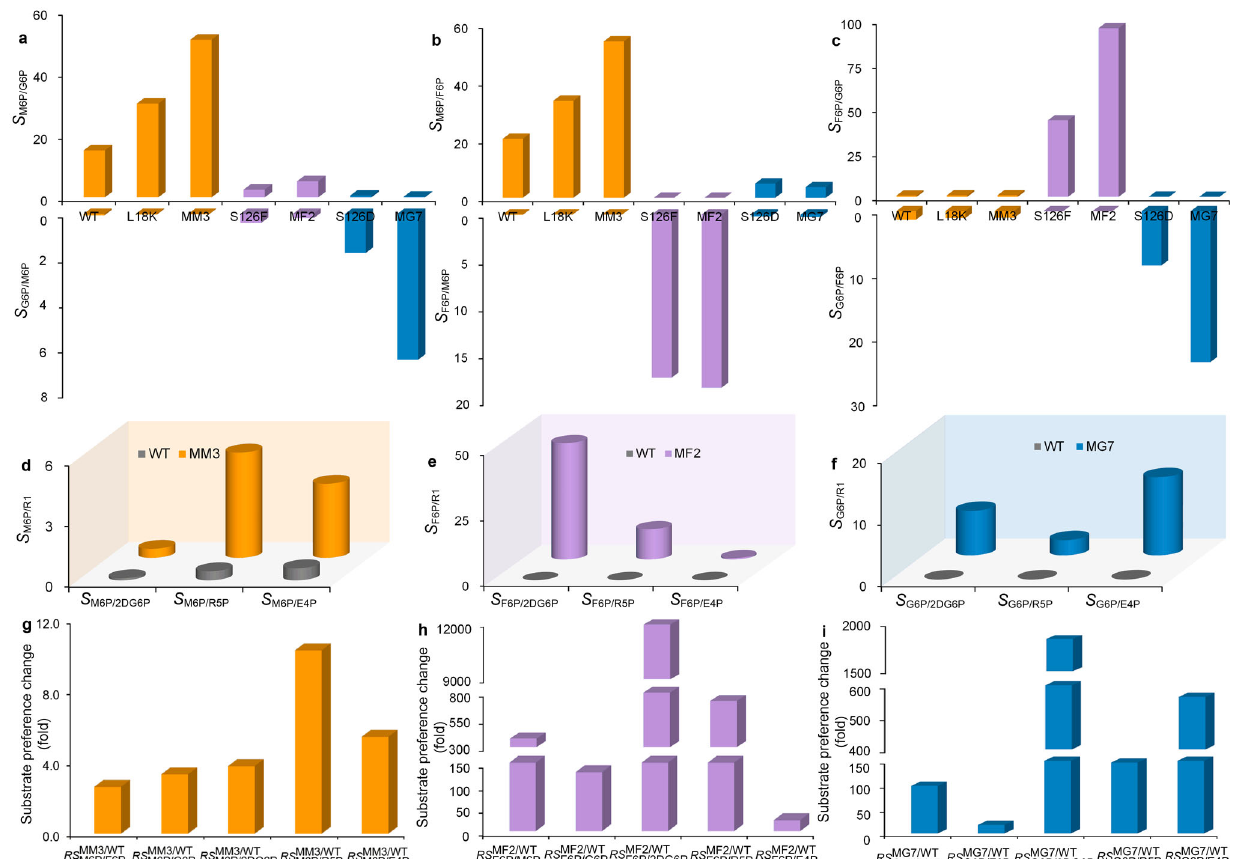
Fig. 3 The SR1/R2 and RS Mutant = WT values of the WT and mutants. a – c represented the S M6P/G6P and S G6P/M6P values, S M6P/F6P and S F6P/M6P values, and R1 = R2 S S S G6P/F6P and F6P/G6P of WT and different mutants, respectively. d The M6P/R2 values of WT and mutant MM3 for M6P over substrates 2DG6P, R5P and E4P. e The S F6P/R2 values of WT and mutant MF2 to F6P over other three substrates. f The S G6P/R2 values of WT and mutant MG7 to G6P over other three substrates. g – i represented the substrate preference change compared with WT. For example, RS MF2 = WT value was calculated by the ratio of S F6P/M6P of F6P = M6P MF2 to that of the WT. 2DG6P:2-deoxy- D -glucose-6-phosphate; R5P: D -ribose-5-phosphate; E4P: D -erythrose-4-phosphate. Source data for Fig. 3 are provided as a Source Data fi